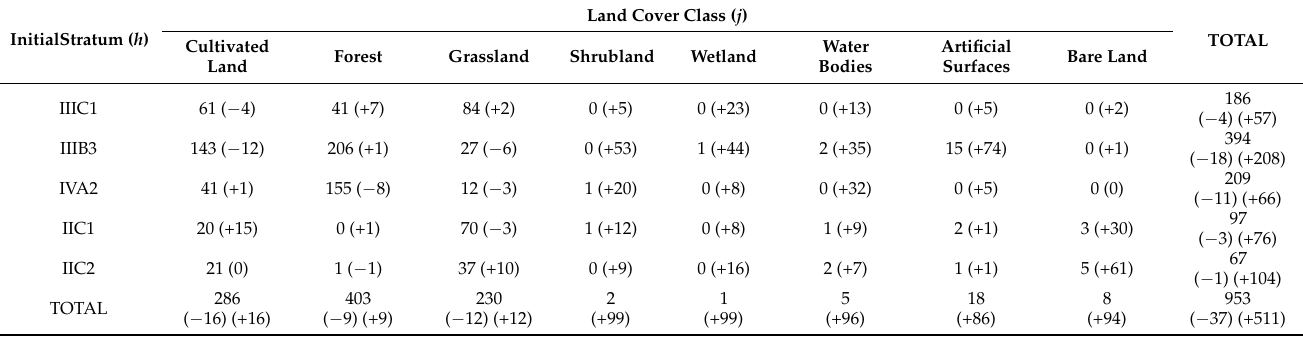
Table A1. Sample size adjustments for GlobeLand30